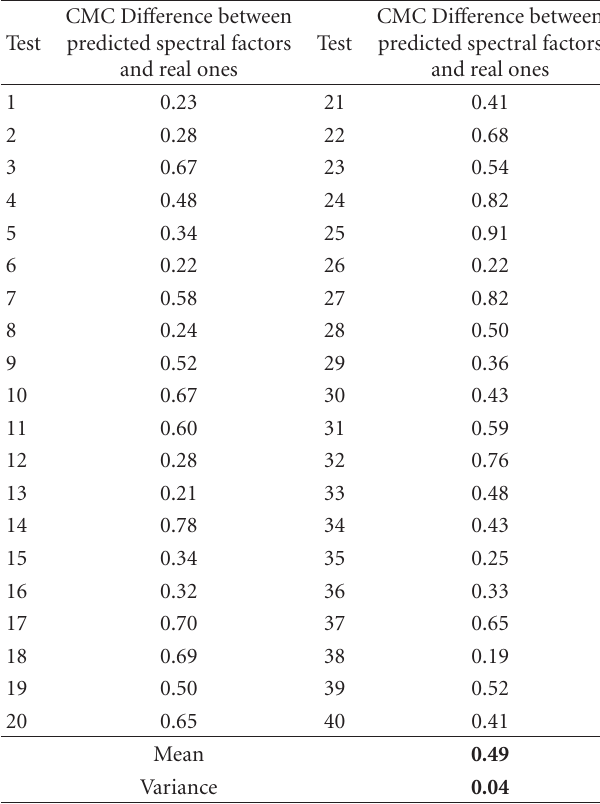
Table 1: Some of the results of the prediction performed by means of the devised ANN. The mean value for CMC colour di ff erence is equal to 0.49 with a variance equal to